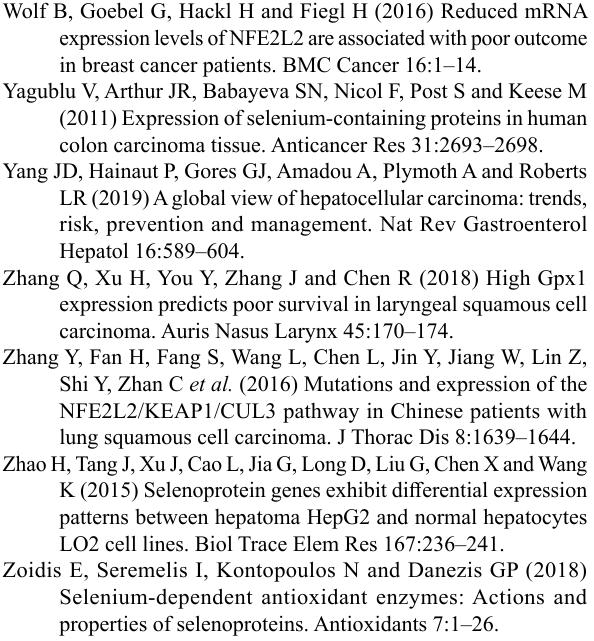
Figure S1 – Sample of agarose gel electrophoresis of total